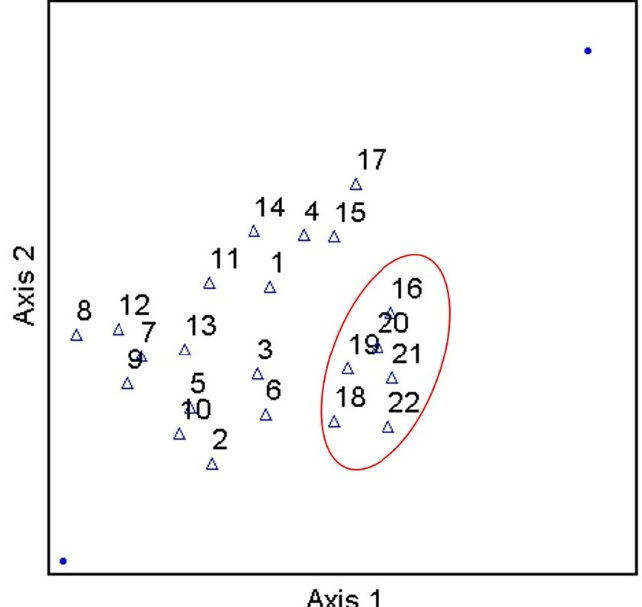
Figure 6. Results of Canonical Correspondence Analysis of stream fecal indicator bacteria and pH data, explaining approximately 53% of the adjusted cumulative variation of site-level bacterial averages, during study period (3 March–3 November 2020) and land use/land cover characteristics in West Run Watershed, WV, USA.